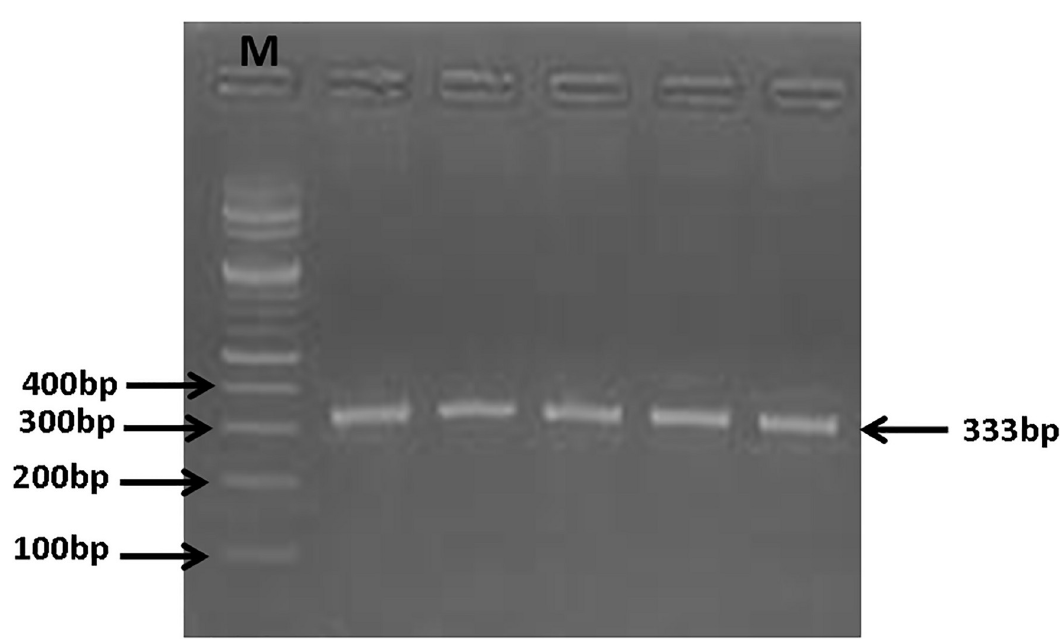
Fig 1. Amplified PCR product of PNPLA3 gene: A representative agarose gel picture showing 333 bp bands that refer to amplified PNPLA3 gene product. M: (100 bp—1.5 kb) DNA ladder.